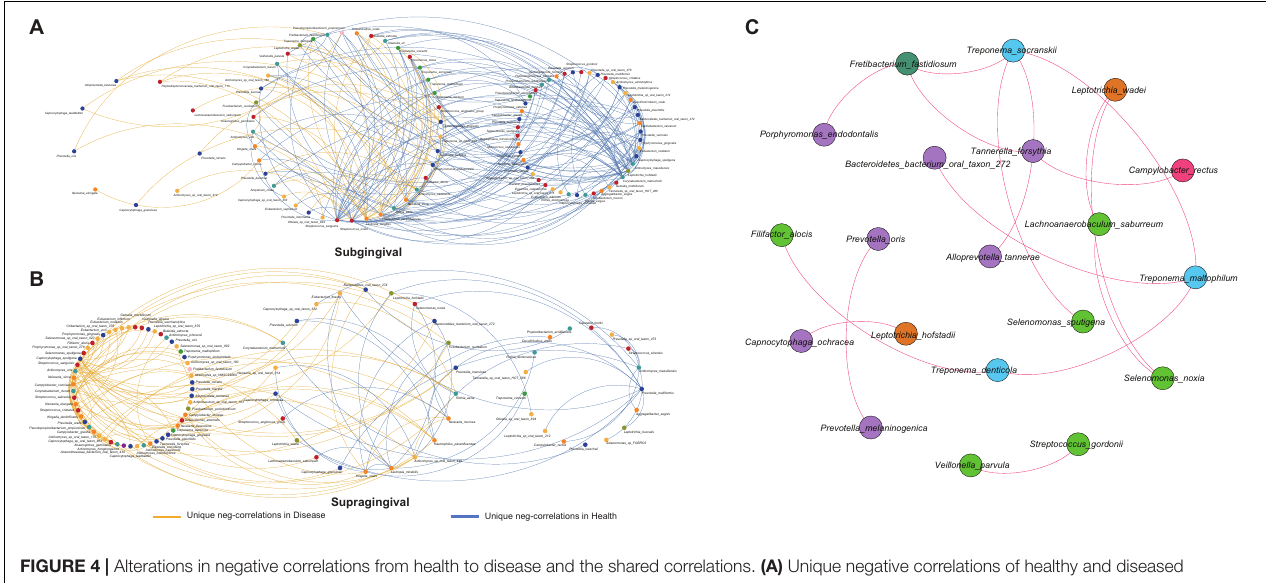
FIGURE 4 | Alterations in negative correlations from health to disease and the shared correlations. (A) Unique negative correlations of healthy and diseased subgingival communities. Streptococcus sanguinis , Streptococcus oralis , Haemophilus parainfluenzae , Rothia aeria , Corynebacterium matruchotii , Leptotrichia hofstadii , Actinomyces massiliensi s, and Capnocytophaga sputigena were the concentrated nodes of negative correlations in health, while Lautropia mirabilis , Actinomyces naeslundii , and Capnocytophaga gingivalis were the concentrated nodes in disease. (B) Unique negative correlations of healthy and diseased supragingival communities. Kingella oralis , Lautropia mirabilis , Prevotella multiformis , and Actinomyces massiliensis were the concentrated nodes of negative correlations in health, while Streptococcus sanguinis , Neisseria sicca , and Capnocytophaga sputigena were the concentrated nodes of negative correlations in disease. (C) The shared correlations of all communities. All shared correlations were positive and were mainly constructed by phyla Bacteroidetes , Firmicutes , and Spirochaetes .